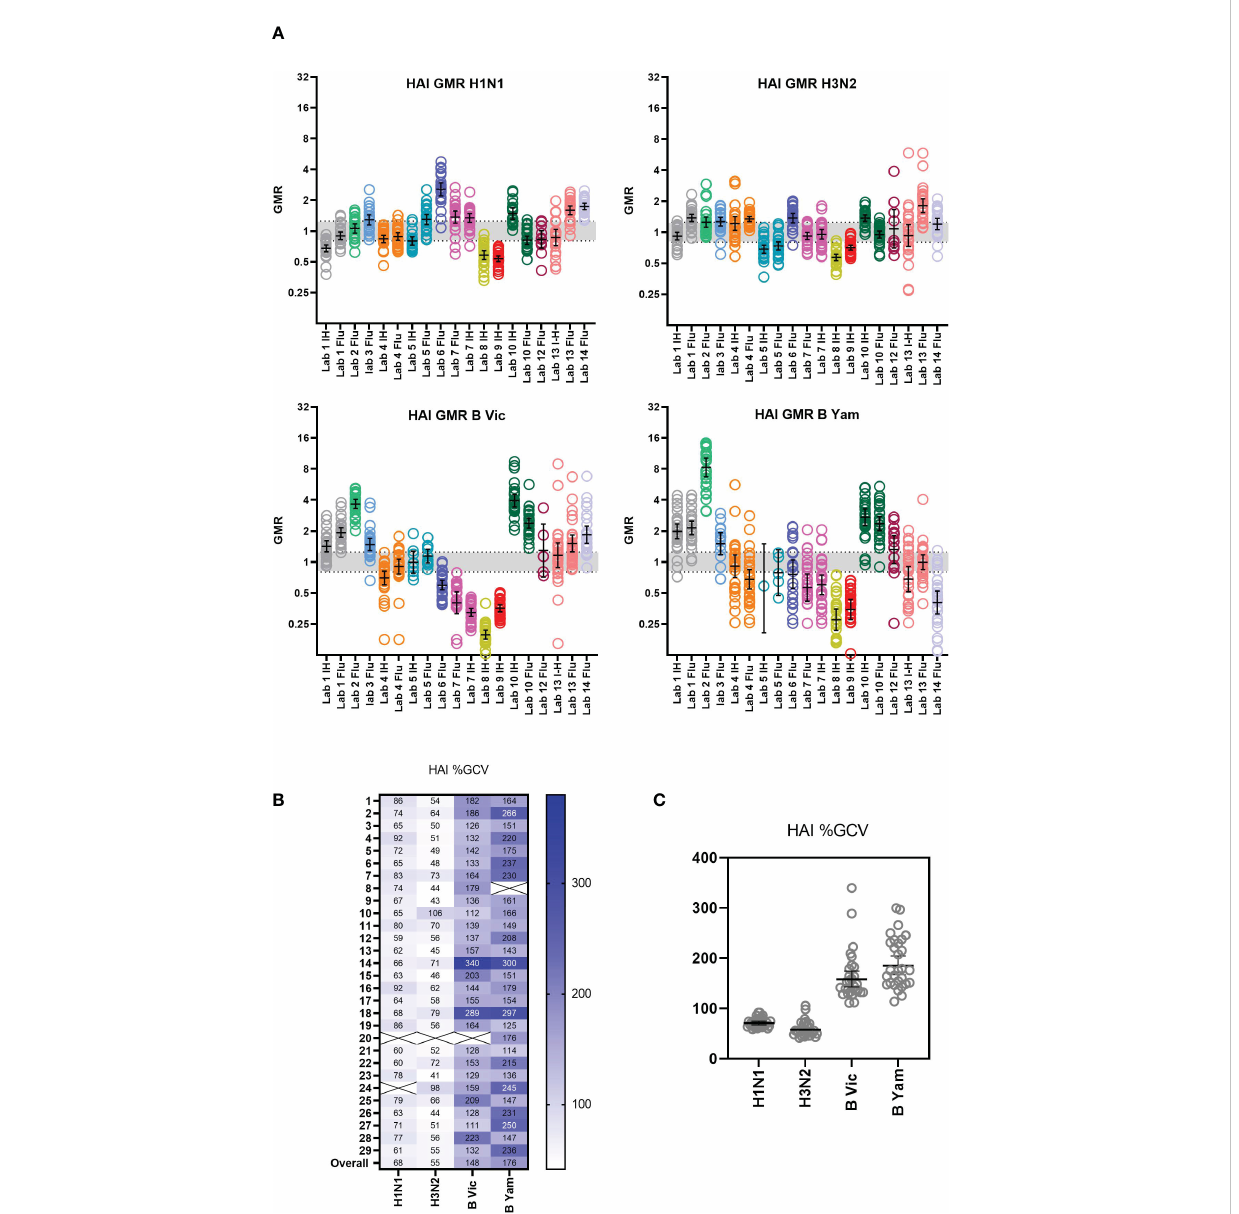
FIGURE 2 Inter-laboratory variation in HAI testing. (A) GMR of each sample HAI titre compared to the global GMT of that sample across all testing laboratories. Geometric mean and 95% CI are shown in black. The indicative interval of 0.8-1.25 is shaded in grey. Each laboratory has a unique number and colour in all graphical representation of data. (B, C) . %GCV of each sample HAI titre across the testing laboratories. Samples with a GMT <10 were excluded from analysis (shown as Xs in B